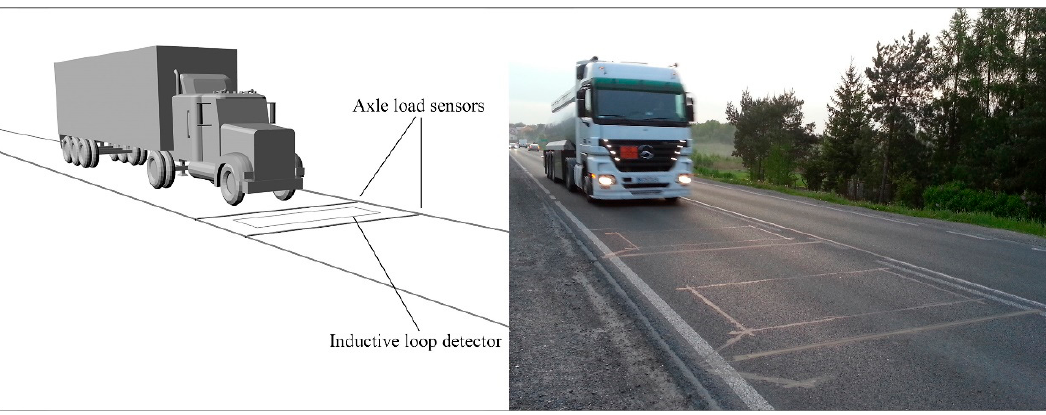
Figure 1. Diagram and photo of a WIM site.